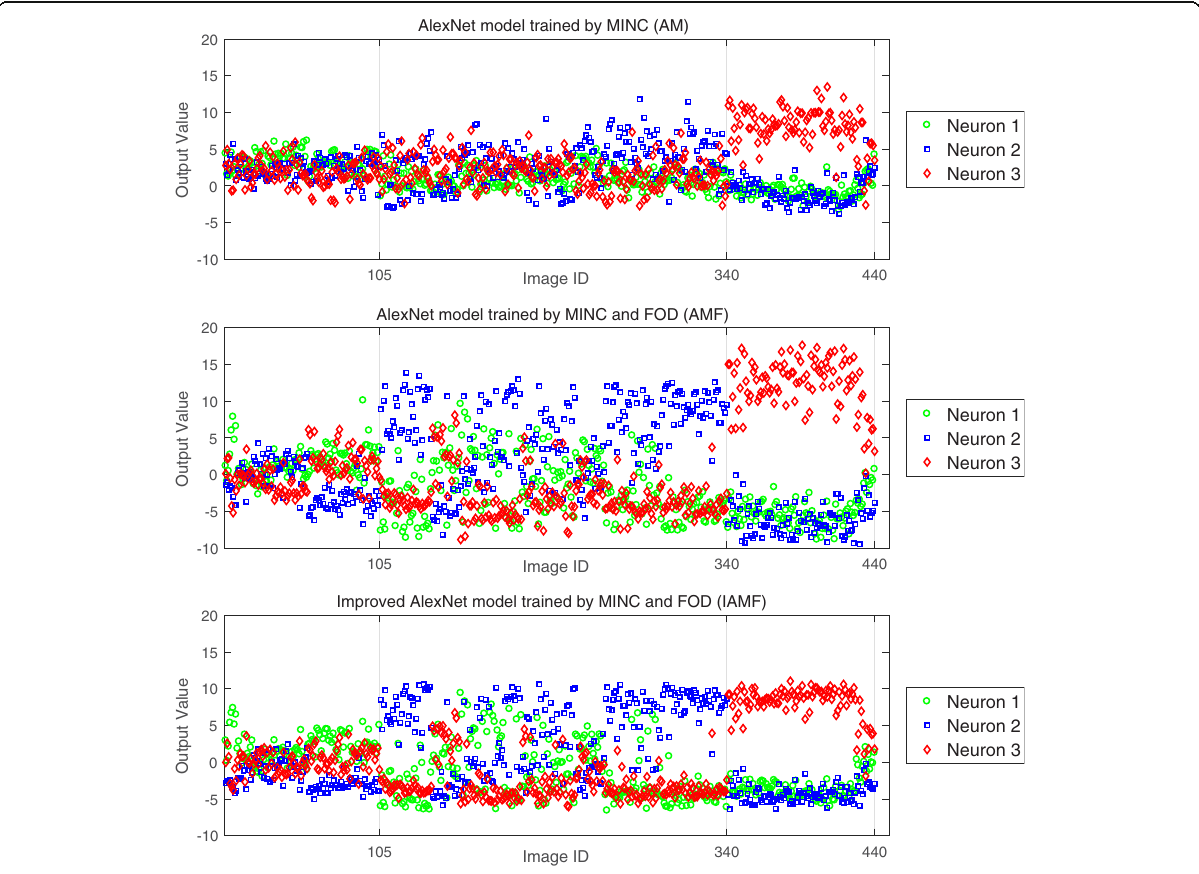
Fig. 10 The neural output value distributions of three convolutional neural